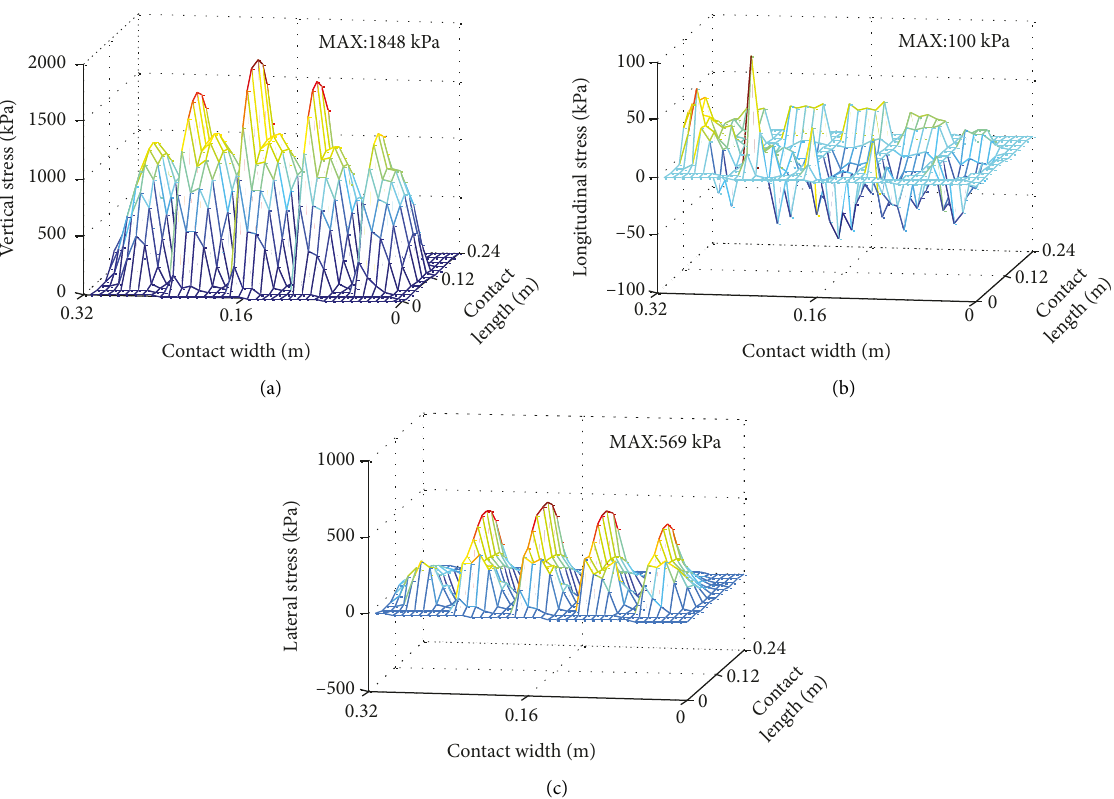
Figure 17: Contact stress under cornering condition: (a) vertical stress, (b) longitudinal stress, and (c) lateral stress.